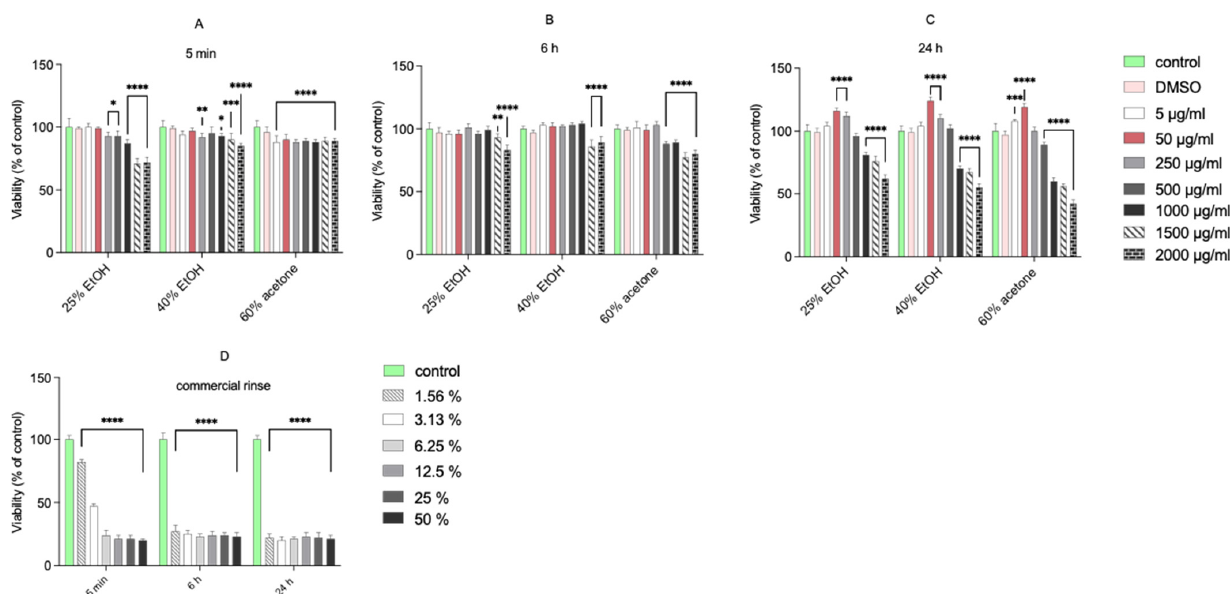
Figure 1. Viability of fibroblast cell line after 5 min ( A ), 6 h ( B ), and 24 h ( C ) incubation following increasing concentrations of different extracts of Reynoutria japonica and commercial rinse ( D ). Note that 25% EtOH, 40% EtOH, and 60% acetone means 25% ethanol extract, 40% ethanol extract, or 60% acetone extract from Reynoutria japonica rhizomes, respectively. The mitochondrial metabolic function (viability) is expressed as a percentage of viable treated cells in relation to untreated control cells. Error bars shown in this figure are means ± SD for n ≥ 6. On the graphs, the statistical differences between the mean of the treatments and the control sample are marked. * Statistically significant at p ≤ 0.05, ** for p ≤ 0.01, *** for p ≤ 0.001, **** for p ≤ 0.0001.